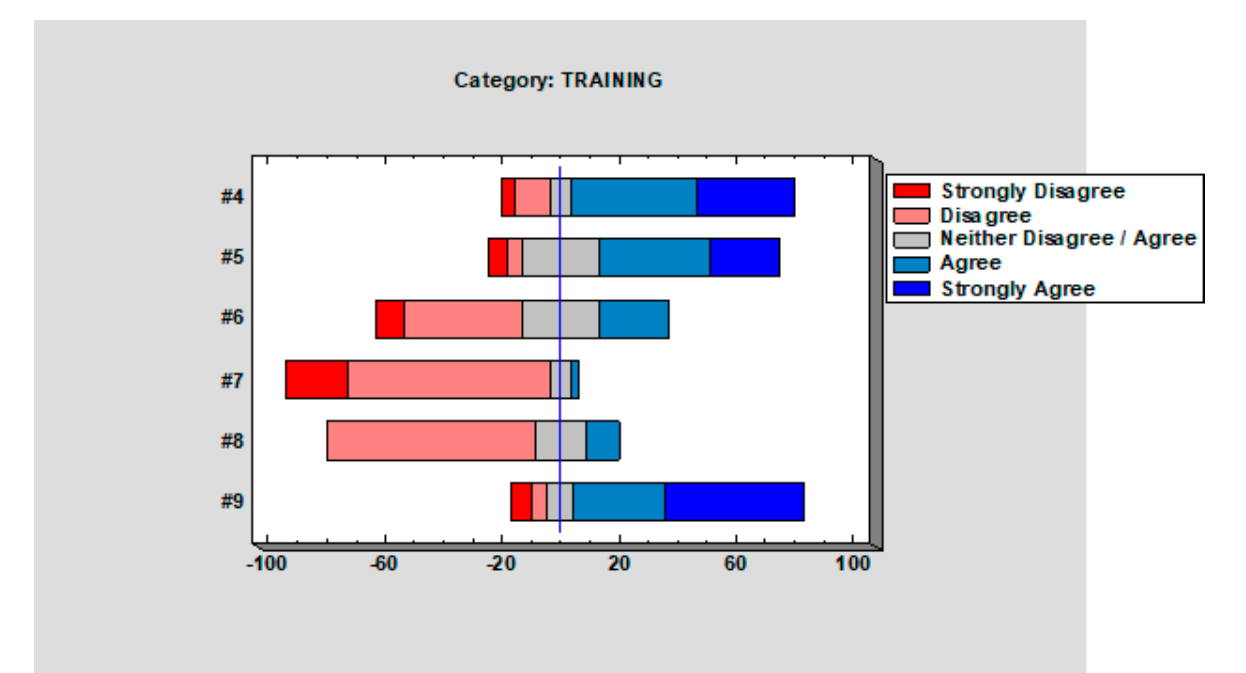
Figure 2. Likert Bar Graph representing scaled Training Category question responses.